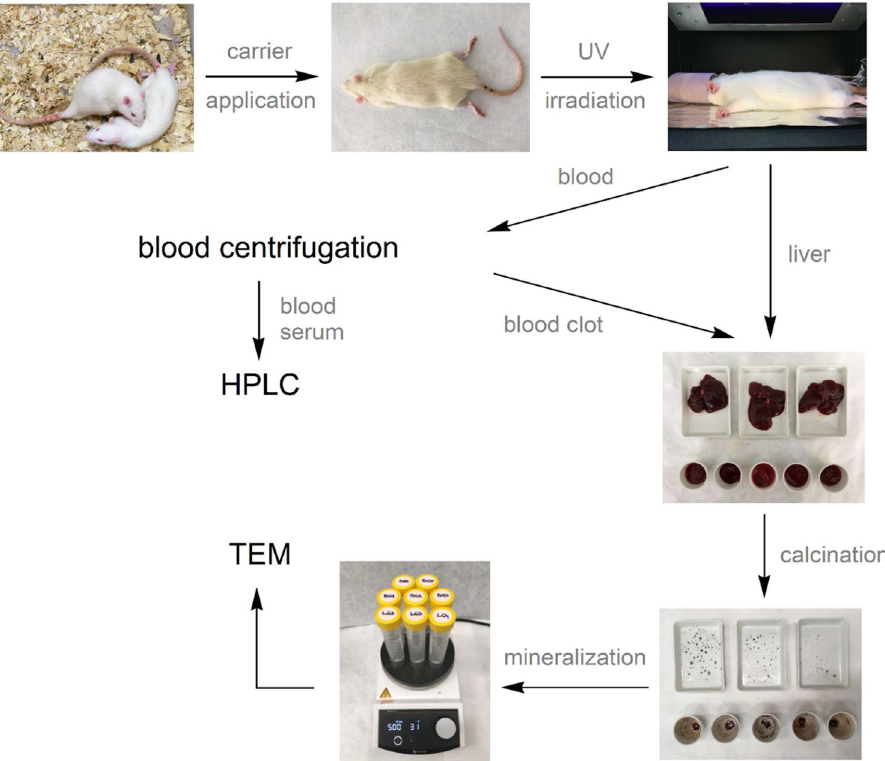
Figure 4. Scheme of in vivo experiments and quantitative/qualitative analysis during the study of effectivity of pore opening in vivo using UV light (for experiment on group of animals denoted as d.) in section “In vivo release